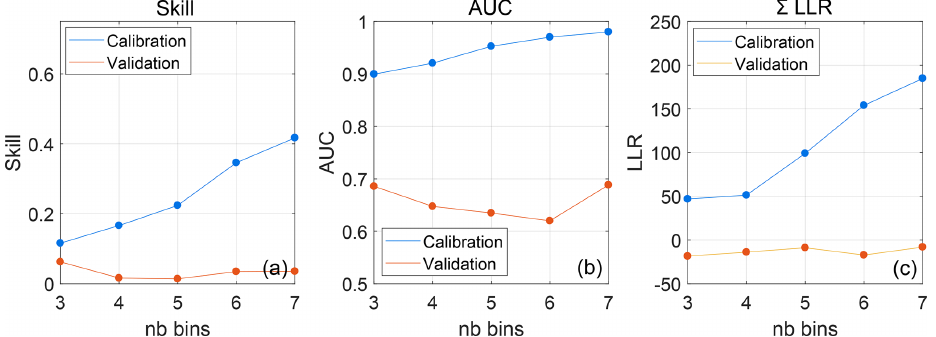
Figure 8. Performance metrics of rip-current BN as a function of the number of bins of the input variables and for validation and calibration: (a) skill sk, (b) area under ROC curve AUC and (c) the summed log likelihood ratio (cid:80) LLR.